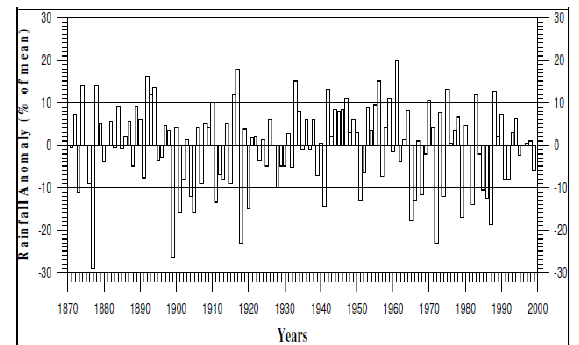
Figure 2. All India summer monsoon rainfall anomalies (1871